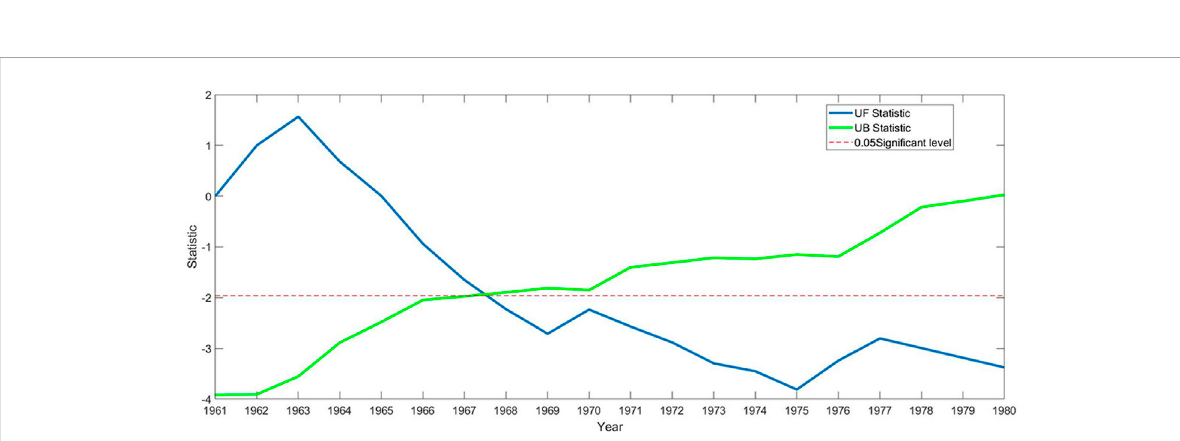
FIGURE 6 Meteorological drought month number mutation test.